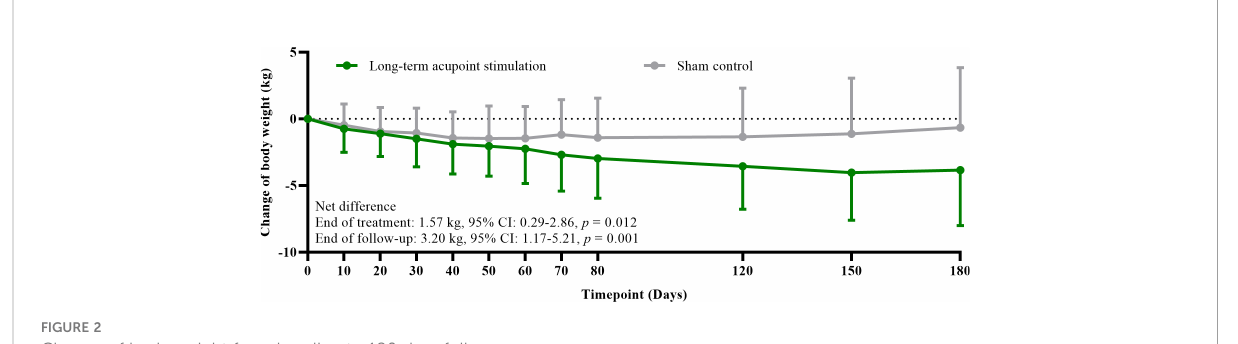
FIGURE 2 Change of body weight from baseline to 180 days